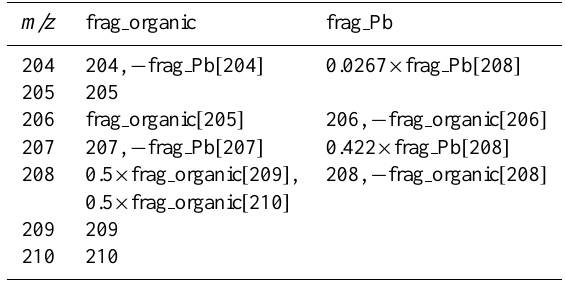
Table 2. Fragmentation table used to determine the Pb signal at m/z 204, 206, 207, and 208 from the C-AMS data.